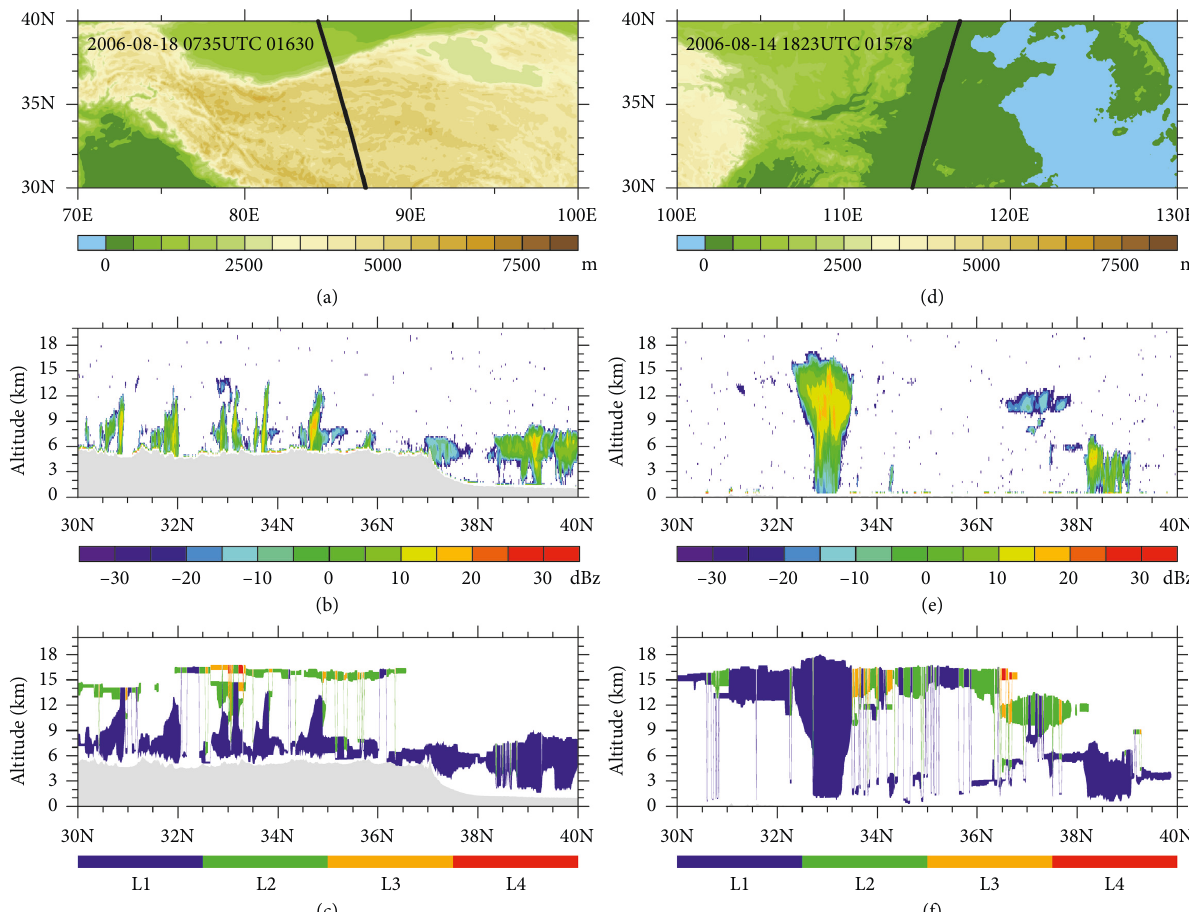
Figure 2: Two cases of clouds over the TP (left panel) and ECP (right panel) detected by CPR and Lidar. (a) and (d): location of the tracks (black solid line) over different elevation area (color shading); (b) and (e): radar reflectivity measured in dBZ (color shading) along the tracks; and (c) and (f): vertical stratification of the clouds, L1 to L4 represent the separate cloud layers from bottom to